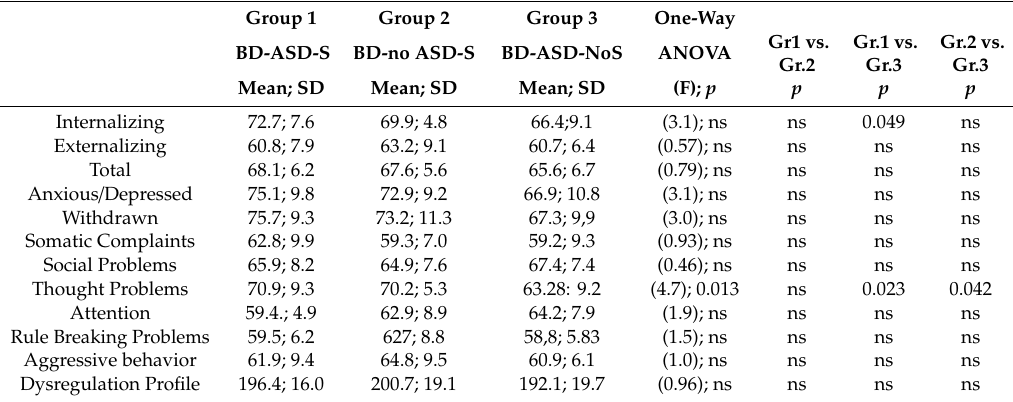
Table 2. Child Behavior Checklist (CBCL): Comparisons among groups. Legenda: BD-ASD-S = Bipolar Disorder + High Functioning Autism Spectrum Disorder + Severe Suicide Ideation or Attempt; BD-noASD-S = Bipolar Disorder + Severe Suicide Ideation or Attempt, without High Functioning Autism Spectrum Disorder; BD-ASD-noS = Bipolar Disorder + High Functioning Autism Spectrum Disorder, without Severe Suicide Ideation or Attempt. Statistical significance at p <